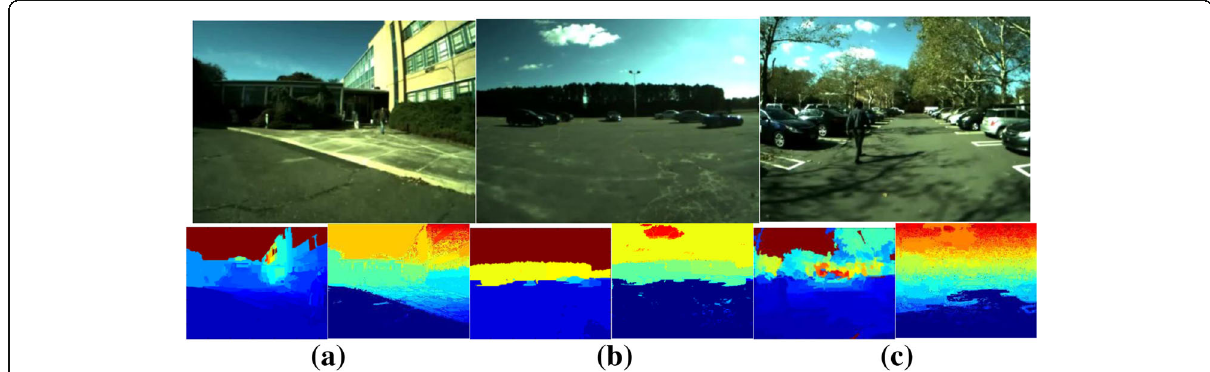
Fig. 15 Comparisons of depth map for three sequences in [6]. a Video 6. b Video 16. c Video 21. Images from upper, left to right are original images, ground truth, and depth maps of the proposed